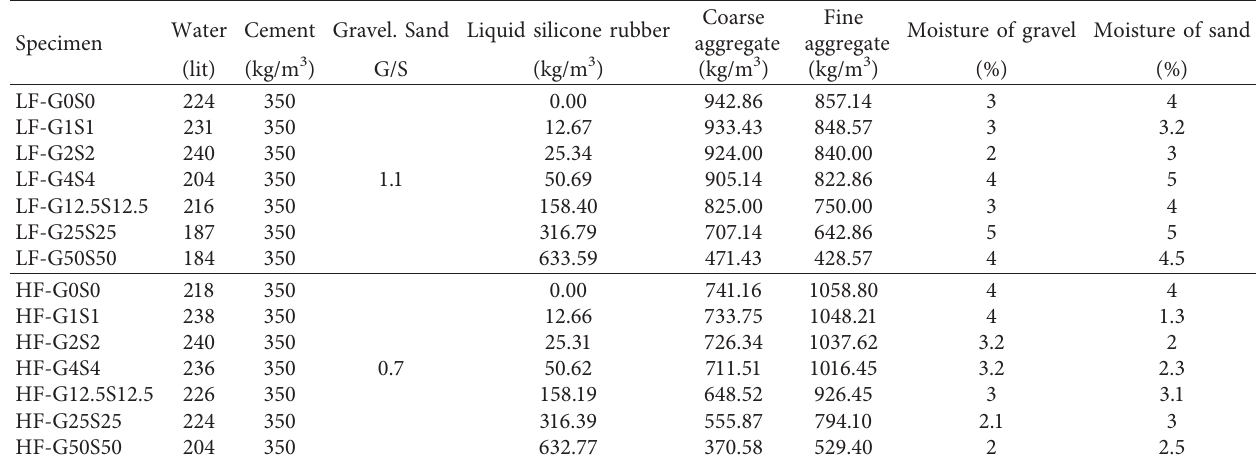
Table 4: Concrete mixture